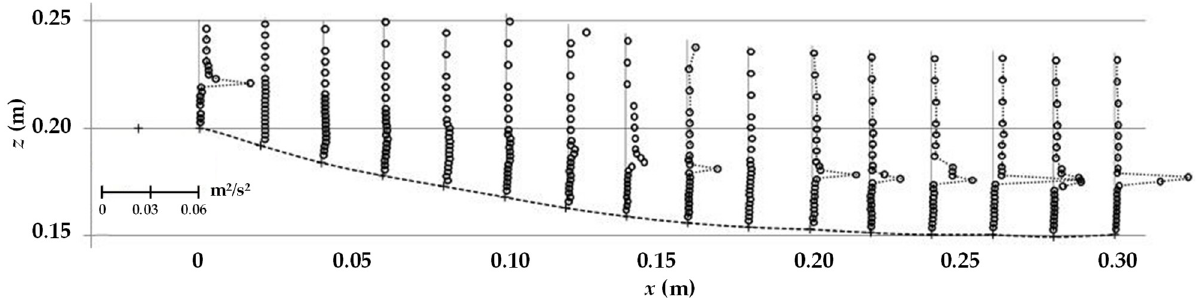
Figure 8. Distribution of turbulent kinetic energy in the scoured hole (modified from [18]).